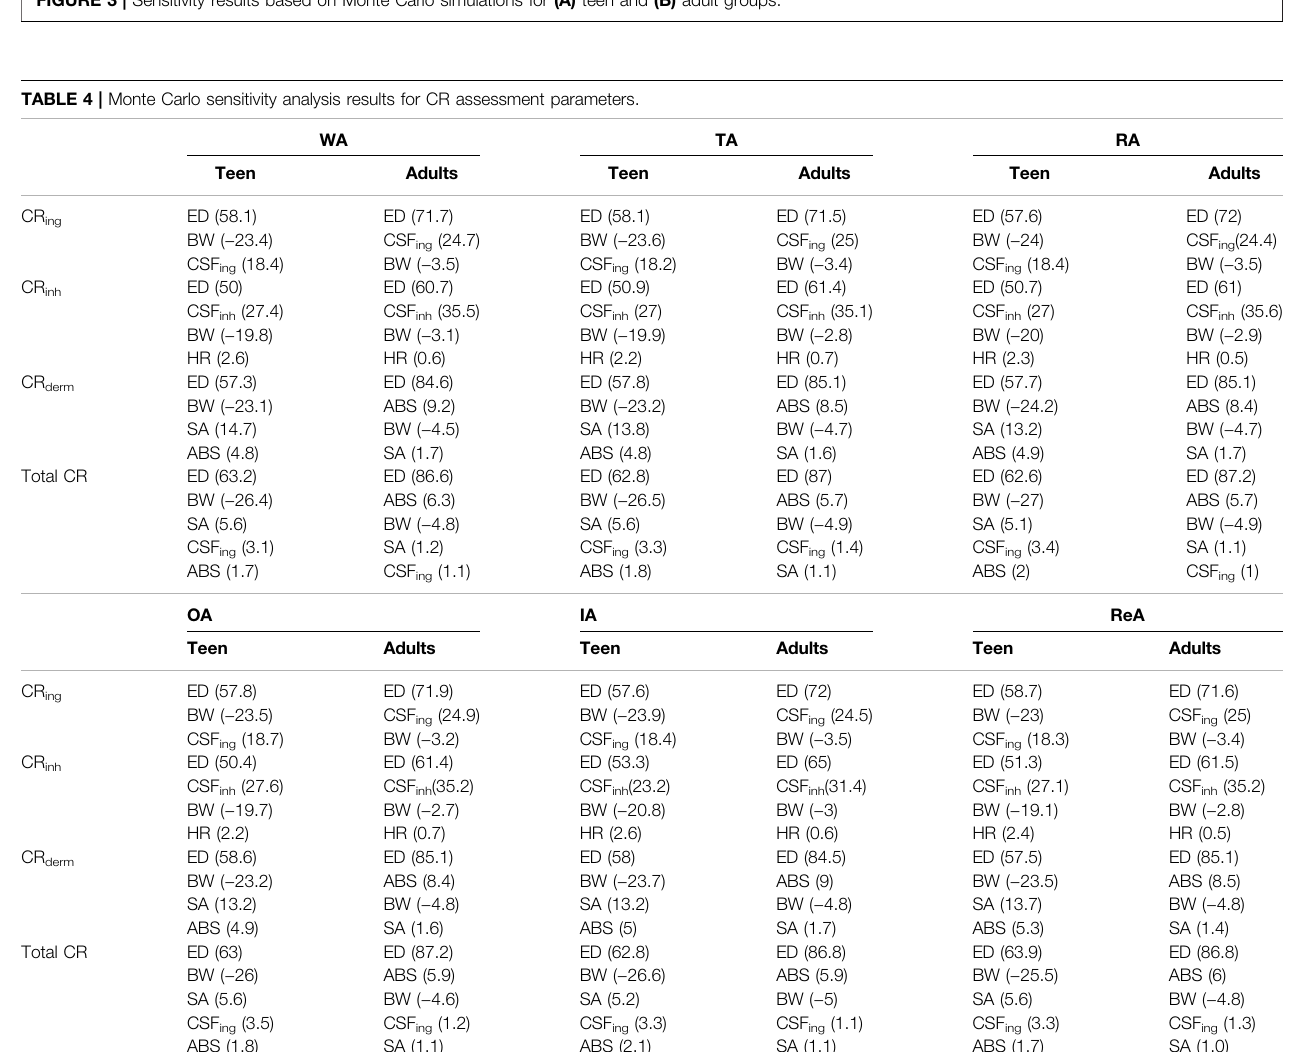
FIGURE 3 | Sensitivity results based on Monte Carlo simulations for (A) teen and (B) adult groups.